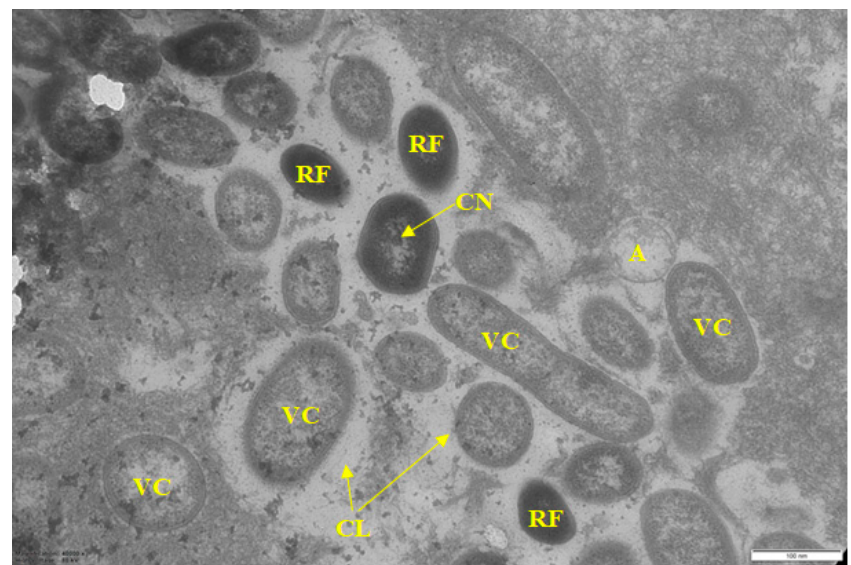
Figure 3. Electron micrograph of sample 2 biofilm. Designations: VC—vegetative cells; G-VC—veg- etative cells of gram-negative bacteria; RF—resting forms; FS—fibrous structures of the matrix; CL—capsular layer; P—persisters; FL—fibrillar layer; A—autolyzed cell. Scale bar is 1 µm.